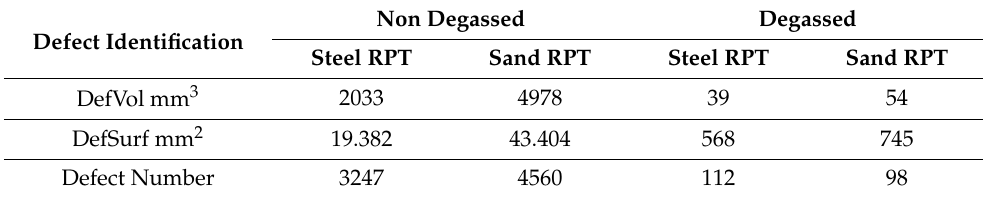
Table 3. Comparison of RPT specimen CT metrics.